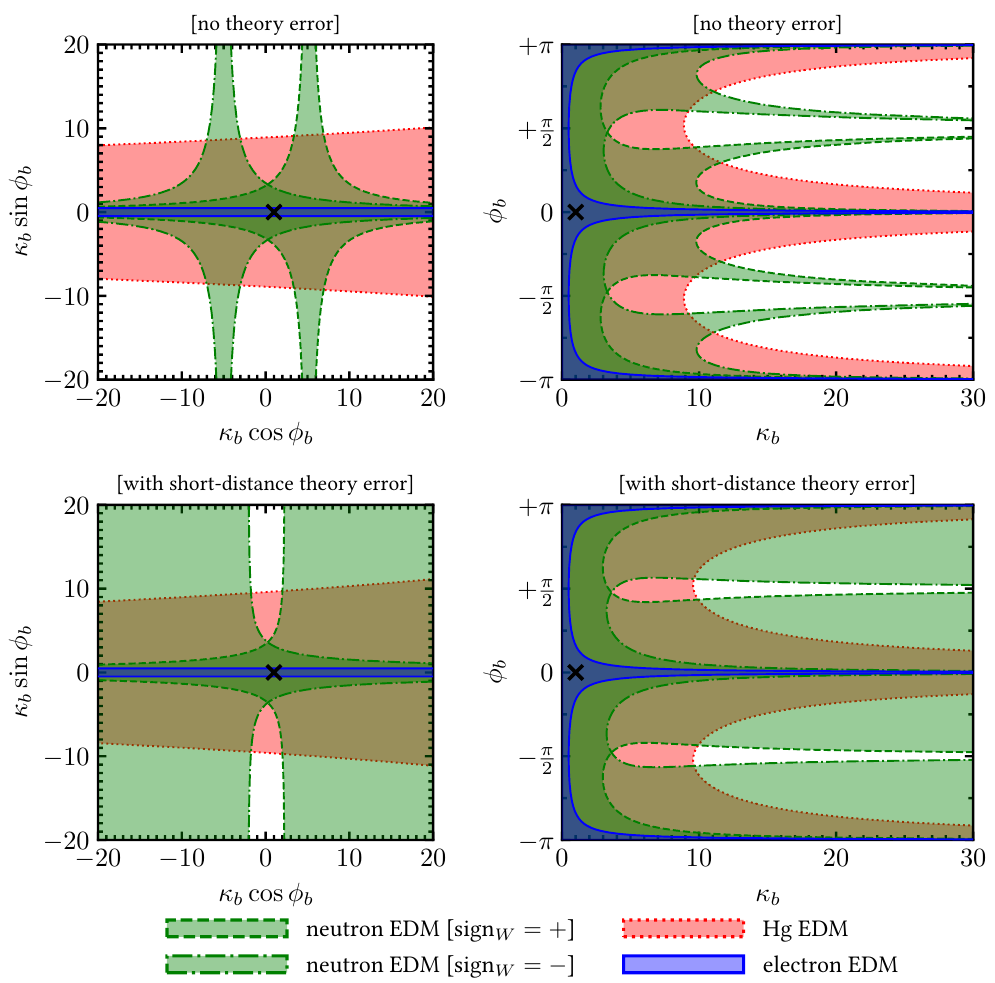
Figure 8 . EDM constraints on anomalous CP violating bottom-quark Yukawas. Coloured are the allowed 68.26% CL regions for the two-parameter space (left: κ b sin φ b and κ b cos φ b , right: κ b and φ b ). In green, the allowed region from the neutron EDM for the case of negative (dashed-dotted line) and positive (dashed line) sign for the Weinberg-operator contribution. In red (dotted line) the allowed region from the mercury EDM, and in blue (solid line) the one from the electron